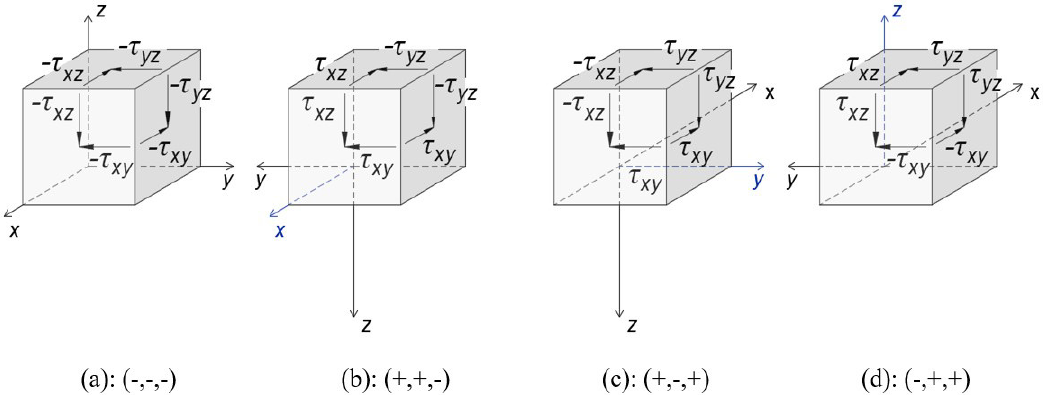
Figure 6. Negative shear stresses in case 2. Legend: (±, ±, ±) = (signal of τ xy , signal of τ xz , signal of τ yz